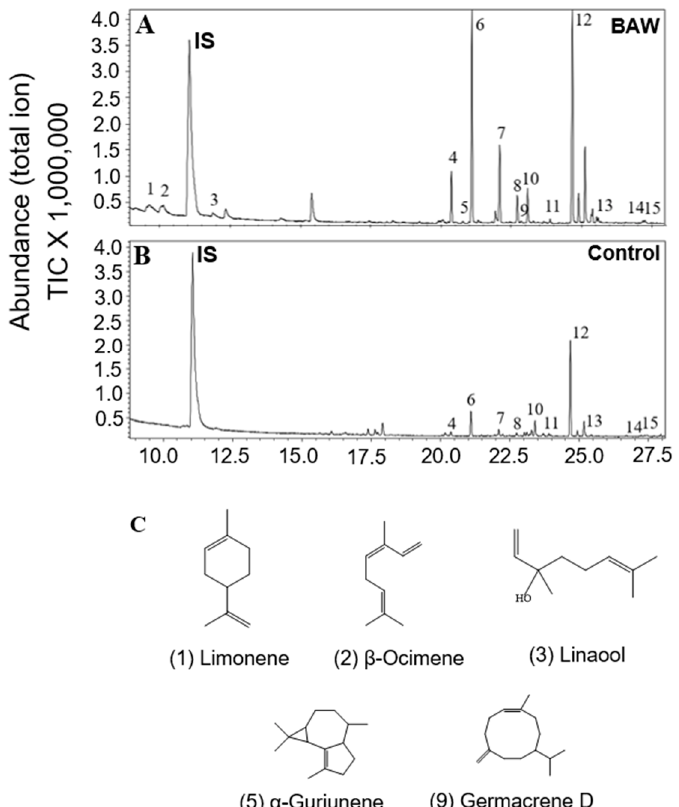
Figure 4. Profile of terpenoids from leaves of BAW infested plants ( A ) and control plants ( B ) by headspace volatile collection and GC-MS analysis. 1, Limonene; 2, β -Ocimene; 3, Linalool; 4, β -Elemene; 6, E- β -Caryophyllene; 7, α -Humulene; 8, α -Bergamotene; 9, Germacrene D; 10, α -Farnesene; 11, Elemol; 12, Hedycaryol; 13, γ -Eudesmol; 14, β -Eudesmol; and 15, α -Eudesmol. Unlabeled peaks are not terpenoids. The internal standard is represented by IS. The chemical structure of terpenoid compounds specifically induced by BAW infestation ( C ).